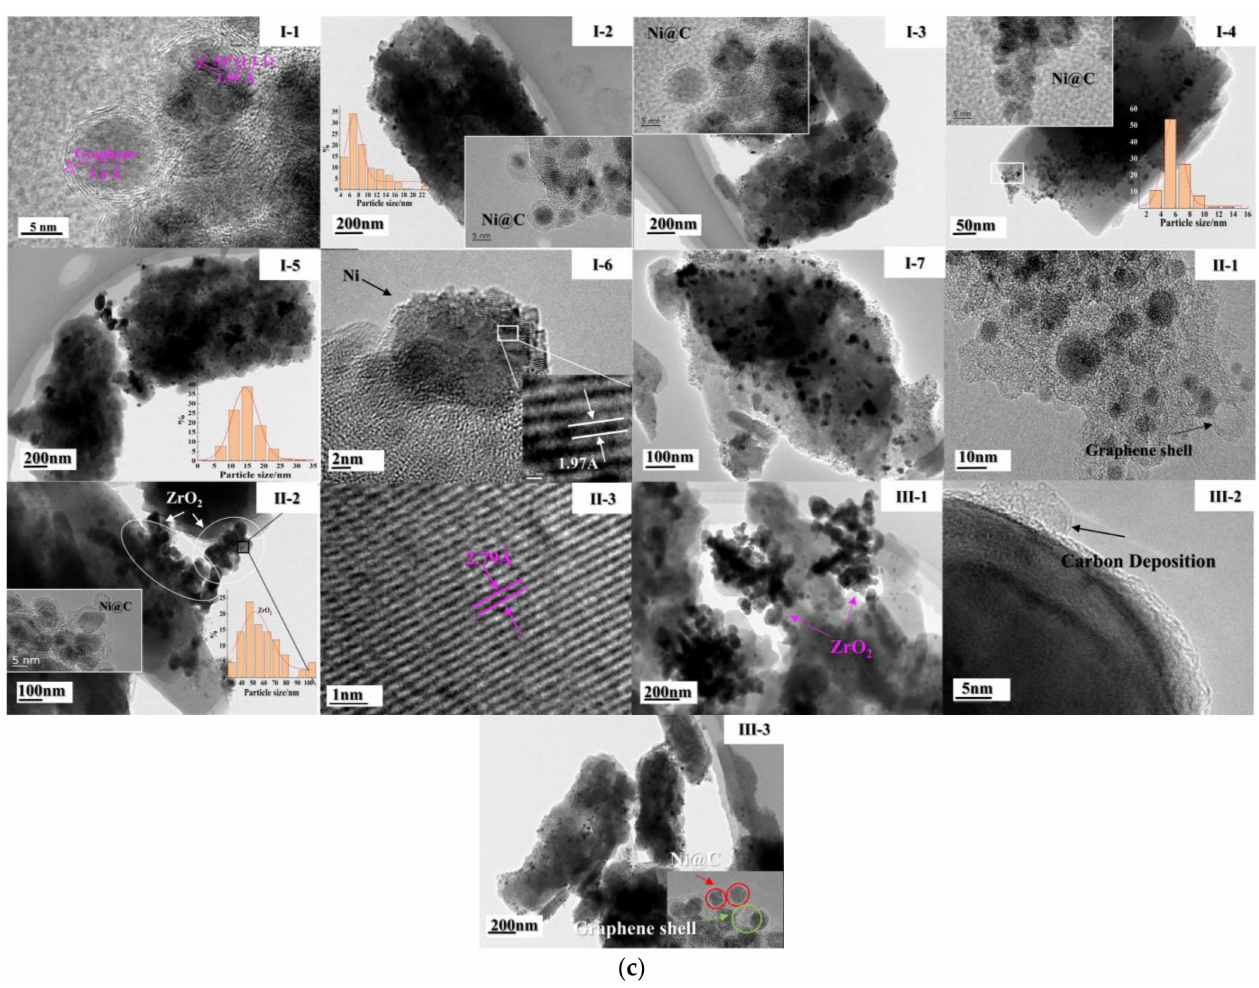
Figure 2. ( a ) XRD patterns of fresh catalysts; ( b ) XRD patterns of catalysts after continuous hy- drogenation (* indicates the diffraction peak position of elemental nickel at 44.6 ◦ ); ( c ) TEM images of the shaped catalysts. I-1 showed TEM images of the typical Ni@C; I-2 showed TEM images